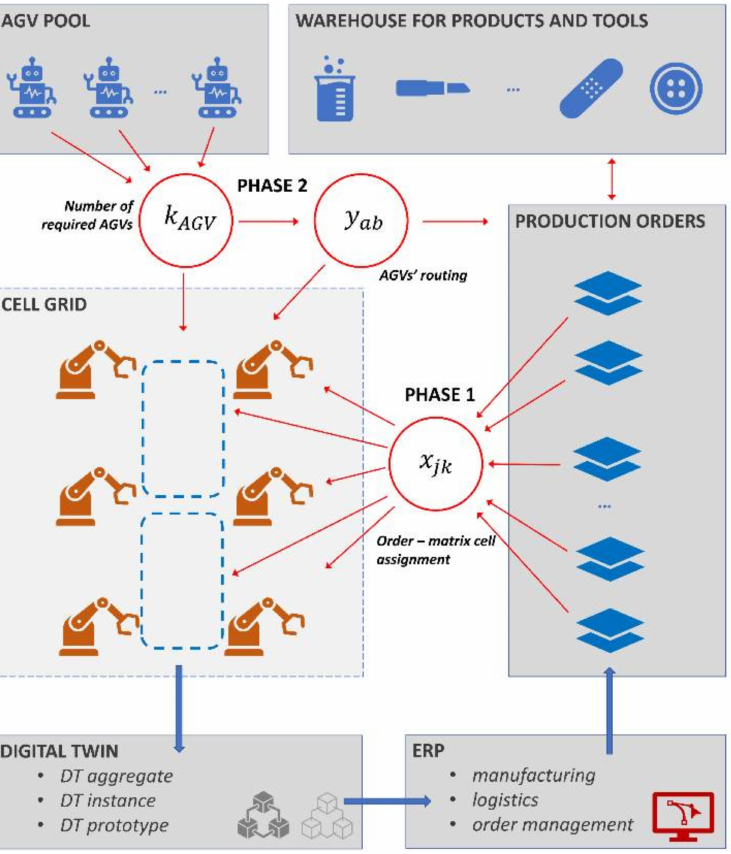
Figure 2. Integrated model of assignment and routing problem in a cyber-physical manufacturing en-